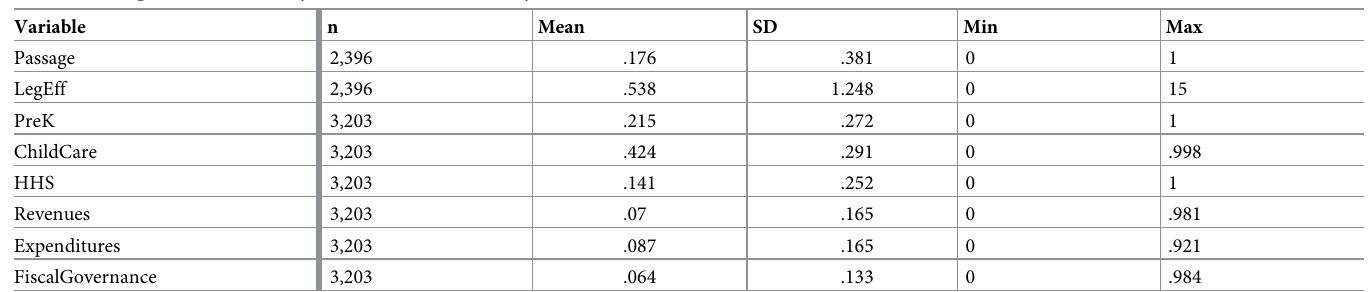
Table 2. Descriptive statistics of key variables used in our